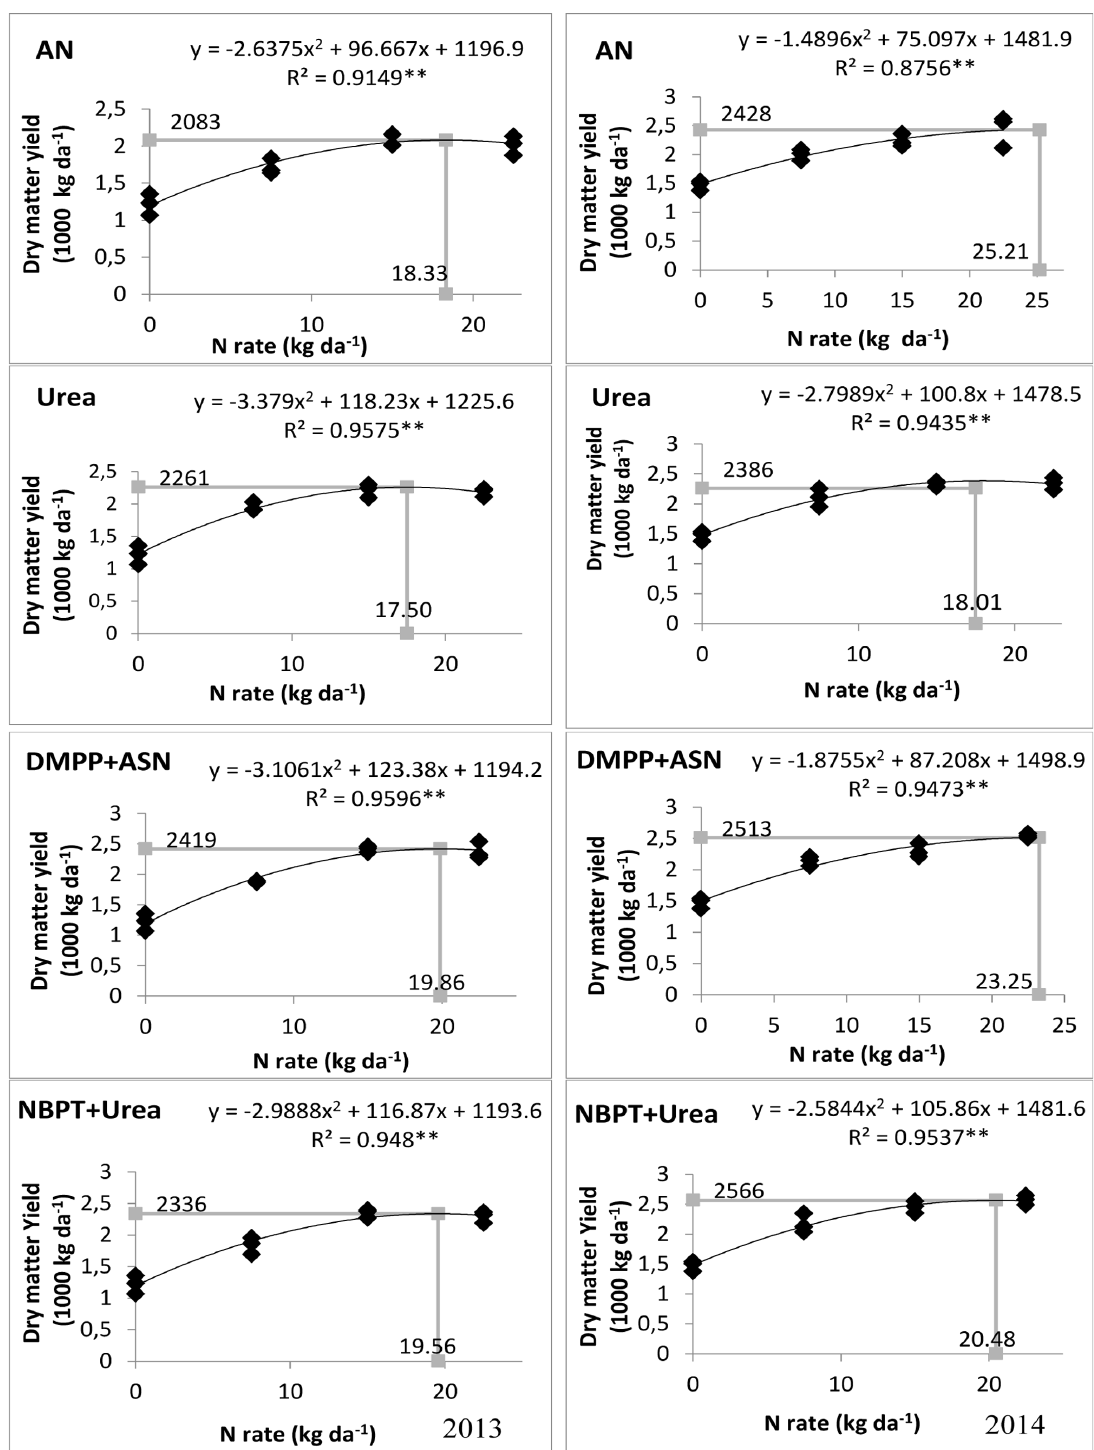
Figure 2. Dry matter yield response of N fertilizer doses and sources of silage maize in 2013-2014, ** P <